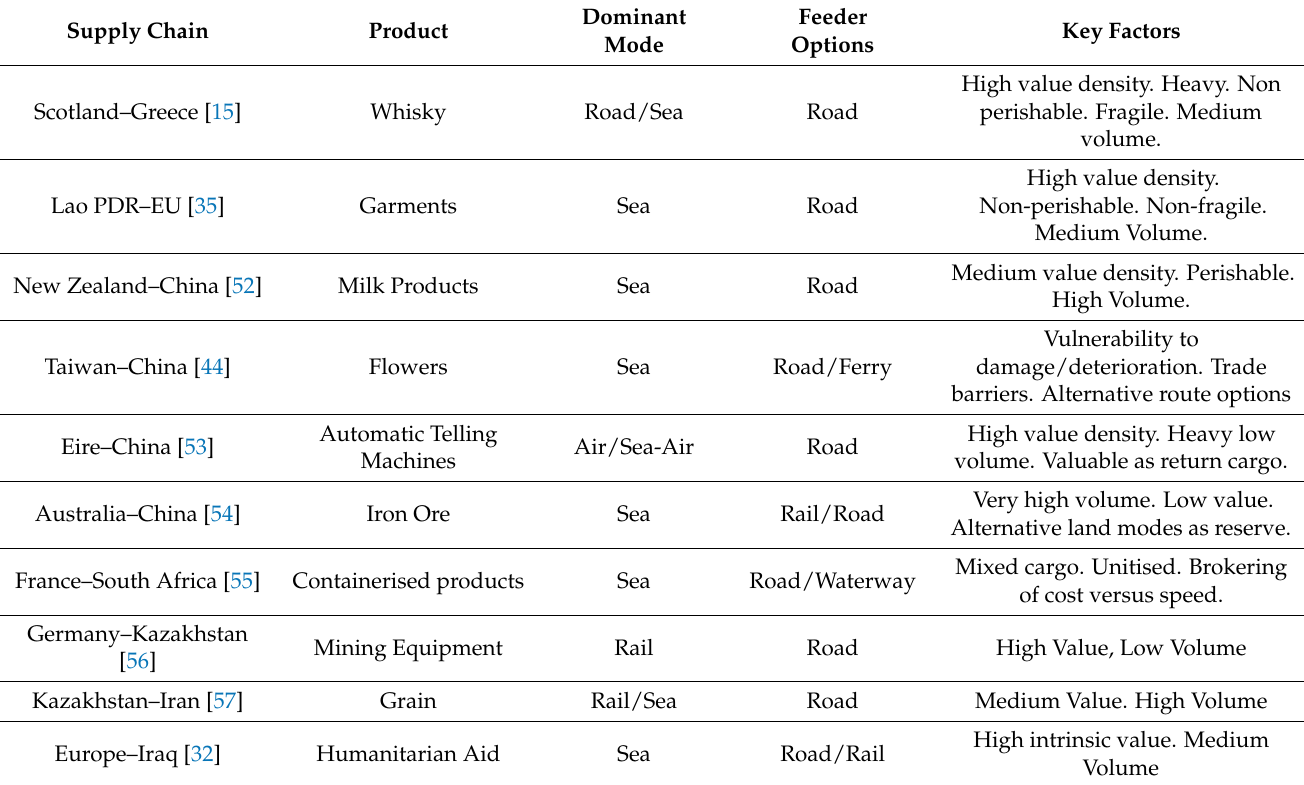
Table 1. Selected Applications of the Multimodal Transport Time/Cost